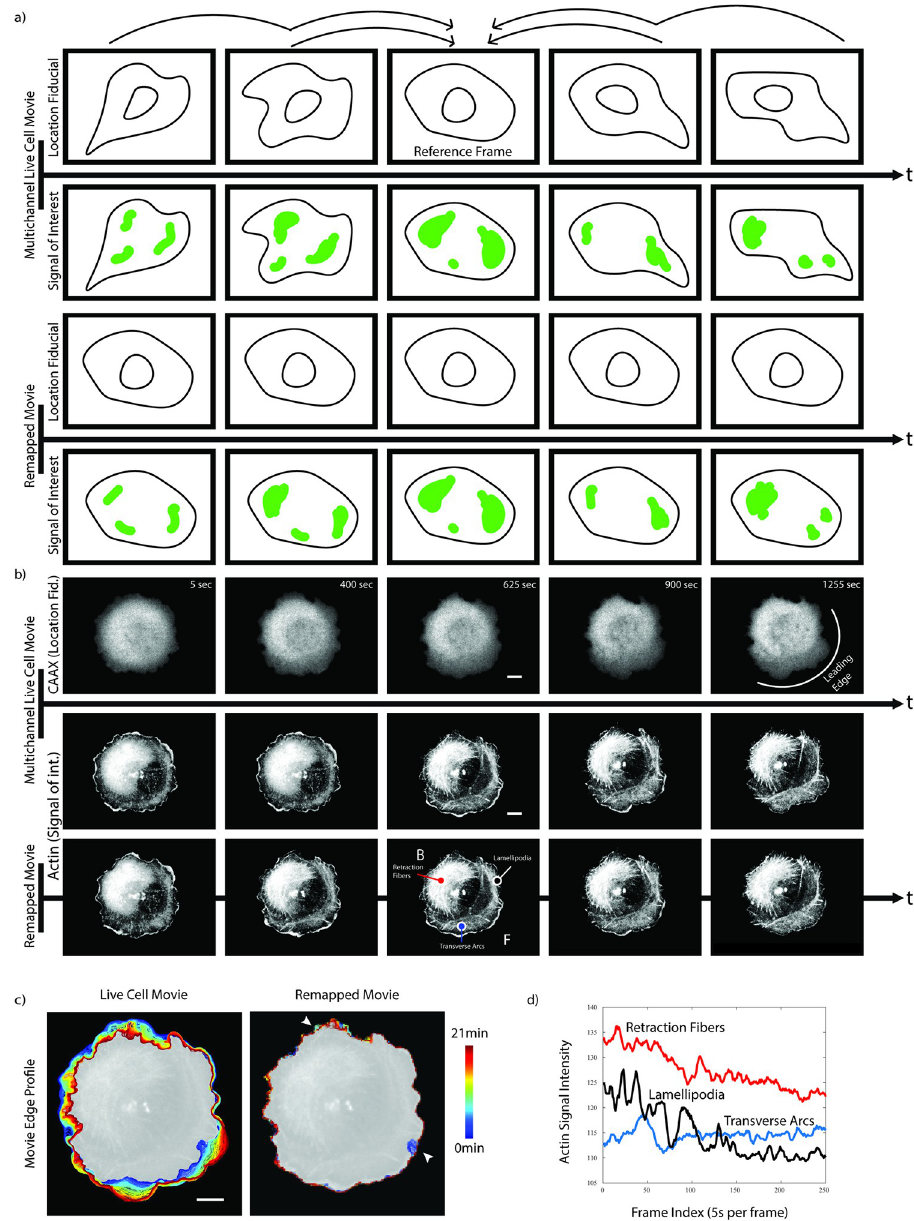
Fig 1. Registration of a signal of interest captured by a live cell movie using a co-imaged location fiducial. a) Illustration of the cell registration pipeline. Top row: The pipeline establishes a frame-by-frame diffeomorphism between all images of a location fiducial time lapse sequence and a reference frame. Without loss of generality, all analyses in this paper rely on the center frame of the sequence as the reference frame. Bottom row: The diffeomorphic functions are applied to remapping a signal of interest from the original movie to a new movie with a rigid geometry defined by the location fiducial reference. The temporal dynamics of the signal of interest is conserved by the remapping process. b) Application of the pipeline to a cell undergoing symmetry breaking, i.e. it transforms from a round geometry to a geometry with front (F)-back (B) polarity (see annotation in the center frame of the remapped Actin signal). The data includes a Halo-CAAX and mNG-Actin time lapse sequence as a location fiducial and as the signal of interest, respectively. Colored points in the center frame of the remapped Actin signal indicate the three positions at which mNG-Actin time-series are sampled in d. c) Cell edge color-coded from blue (early time points) to red (late time points) in the geometry of the original movie (left) and in the geometry of the reference frame (right). With the exception of two regions with strong, intermittent ruffling activity (arrowheads), the registration produces a stationary cell edge. d) The registration of the time lapse image sequence in a spatially stationary reference frame